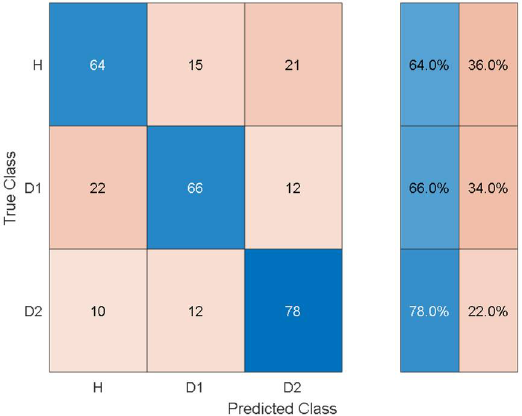
Figure 7. Training/validation confusion matrix for the Fine Tree classifier using handcrafted statistical features from experimental data.